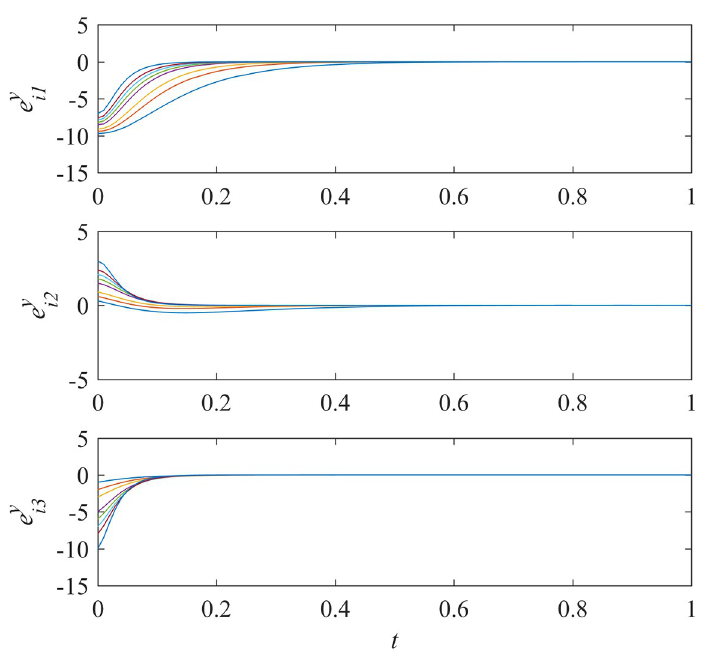
Fig 10. States of error system between the remaining nodes and the isolate node in sub-network Y with the failed node 4 and 9 for the cascading failure.